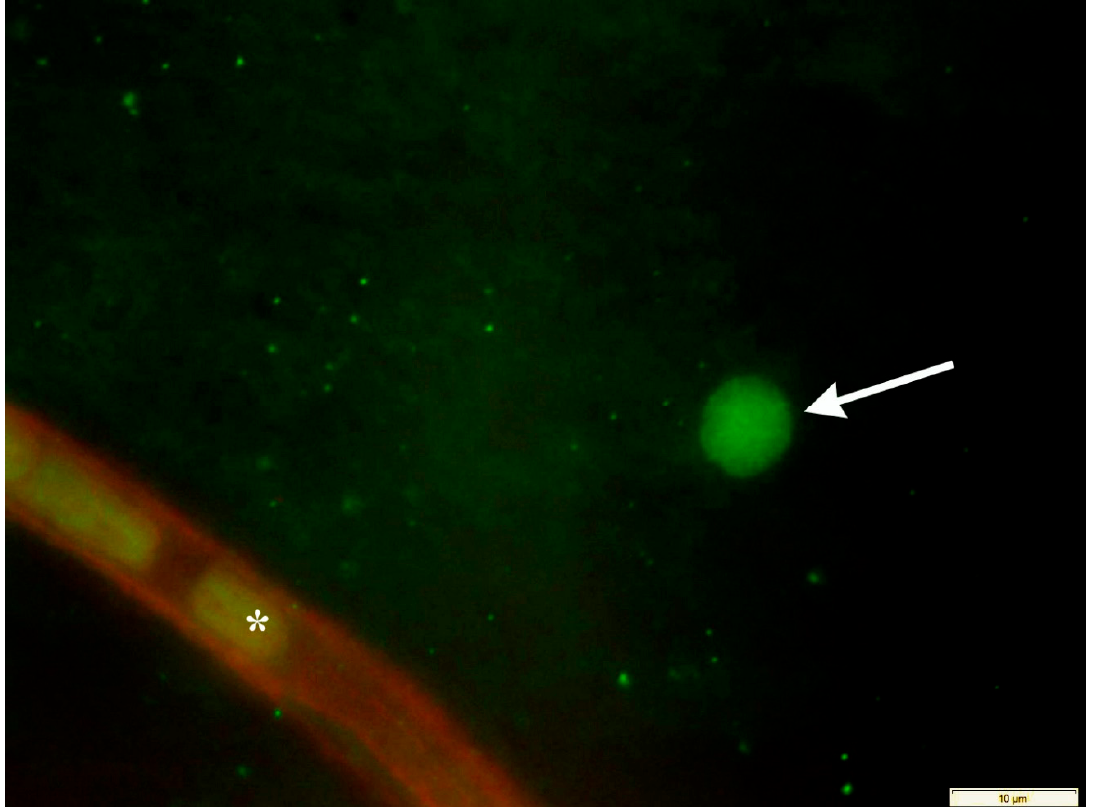
Figure 2. Detection of CD3 positive cells (green) by confocal microscopy in the whole mounted retina of a healthy human eye. While most cells reacting with an anti-CD3 polyclonal antibody (Abcam) are visible within the vasculature (asterisk), a small number of extravasated T-cells (arrow) are regularly observed.